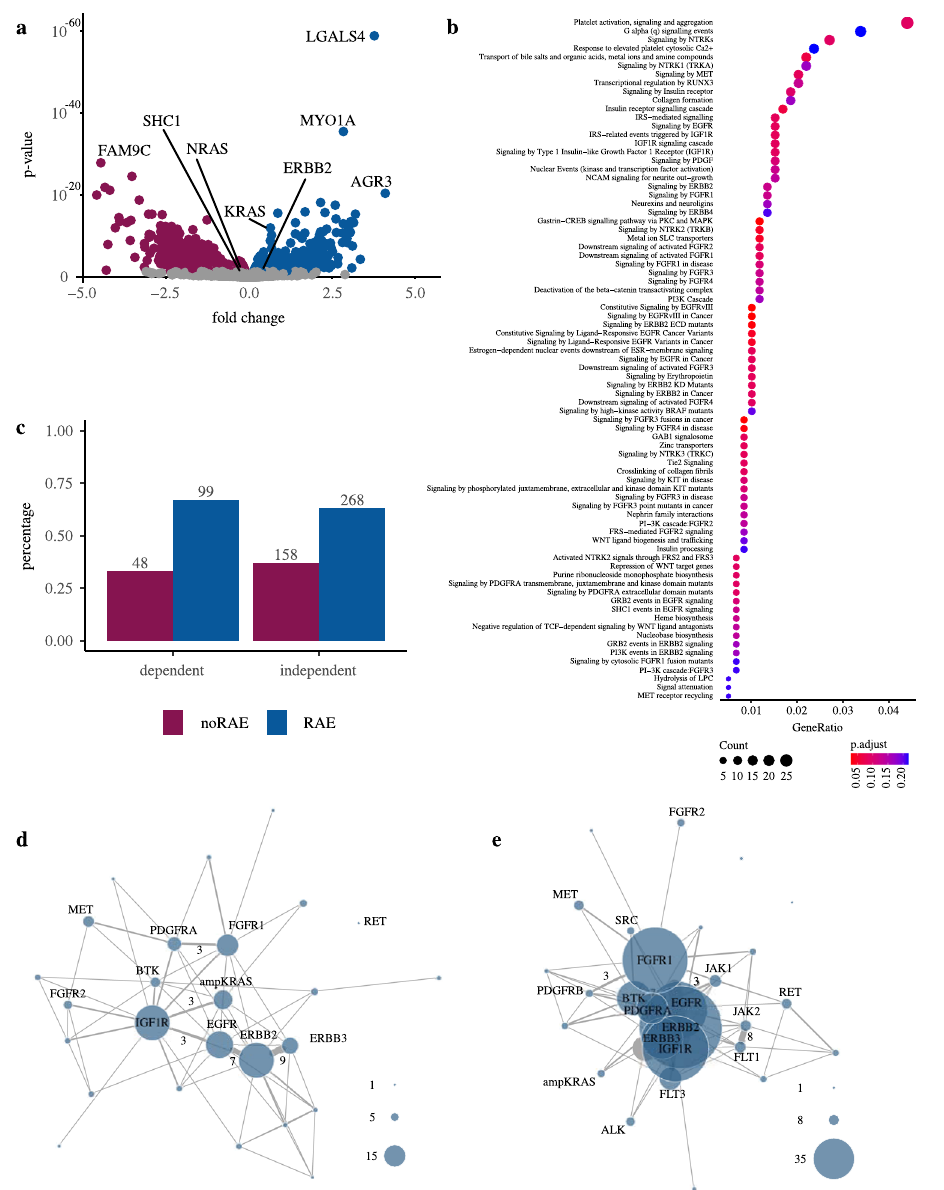
Fig. 3 Transcriptional characterization and dependency analysis of KRAS dependent KRAS wt cell lines. a Differentially expressed genes in KRAS wt dependent vs independent cell lines ( n = 567). Positive values on the x -axis re fl ect higher expression in the dependent subgroup, correspondingly negative values re fl ect higher expression in the independent subgroup. b Overrepresentation analysis (Reactome) of genome wide CRISPR screen genes exhibiting a higher dependency in the KRAS wt dependent subgroup (Wilcoxon – Mann – Whitney Test; n genes = 1038). c Percentage of cell lines harboring at least one RAE (blue) or no RAE (purple) in KRAS wt subgroup for KRAS dependent (left) and independent (right) cell lines. Absolute values are shown above each column. d , e Binary co-dependency network of RAE in KRAS wt highlighting the heterogeneous distribution of RAE (Dependent cell lines ( d ), independent ( e )). Number of co-dependencies shared between two genes is shown if there were more than two co-dependencies. Node size refers to the number of cell lines classi fi ed as dependent on the respective gene. Cell lines without RAE were not included in the fi